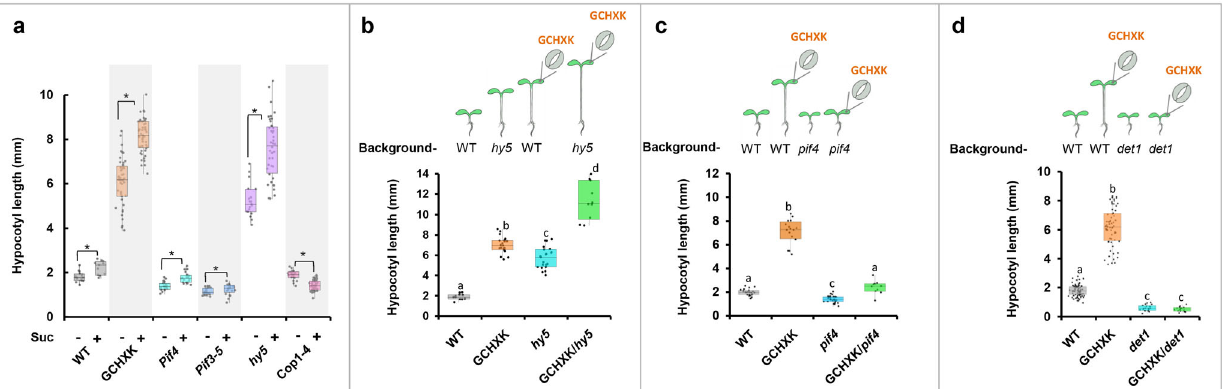
Fig. 4 Hypocotyl lengths of mutants treated with sucrose and the combined effects of GCHXK with hy5 , pif4 , and det1 mutants. a Hypocotyl lengths of 7-day-old WT, GCHXK, pif4 , pif3-5 , hy5 , and cop1-4 seedlings grown under long-day conditions with or without 1% sucrose. b – d Hypocotyl lengths of ( b ) GCHXK/ hy5 , ( c ) GCHXK/ pif4 , and ( d ) GCHXK/ det1 seedlings grown on 0.5× MS agar media with 1% sucrose. a – d The box plots extend from the fi rst to third quartiles and the whiskers extend from the minimum to the maximum levels. Lines within the boxes signify median values and gray dots represent individual data points ( n ≥ 10 for a – c ; n = 20 – 40 for d ). a Asterisks indicate a signi fi cant difference relative to the control ( t test, P < 0.05). b – d Different letters indicate a signi fi cant difference (Tukey ’ s HSD test, P < 0.05). The illustration above each fi gure indicates the gene expressed in guard cells, the genomic background (WT, hy5 , pif4 , or det1 ) and the hypocotyl-growth